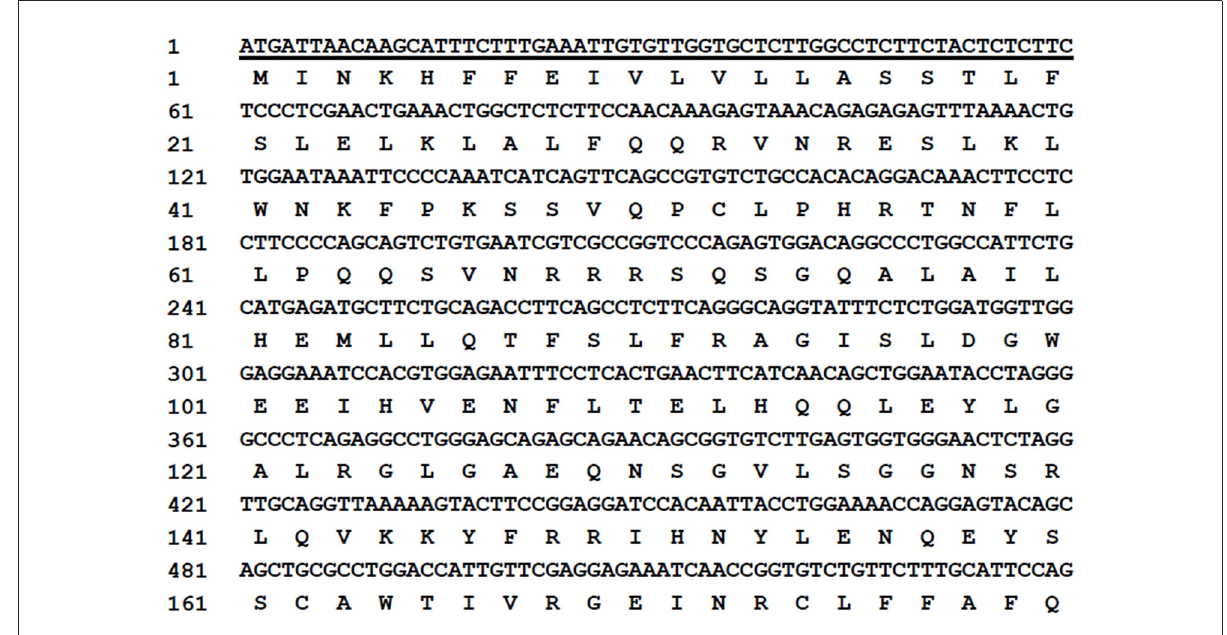
FIGURE1 Nucleotide sequence and inferred amino acid sequences of the mink interferon (MiIFN)- ε -encoding gene. The amino acid sequences are presented under the nucleotide sequence. The underlined sequence represents the signal peptide gene coding region.